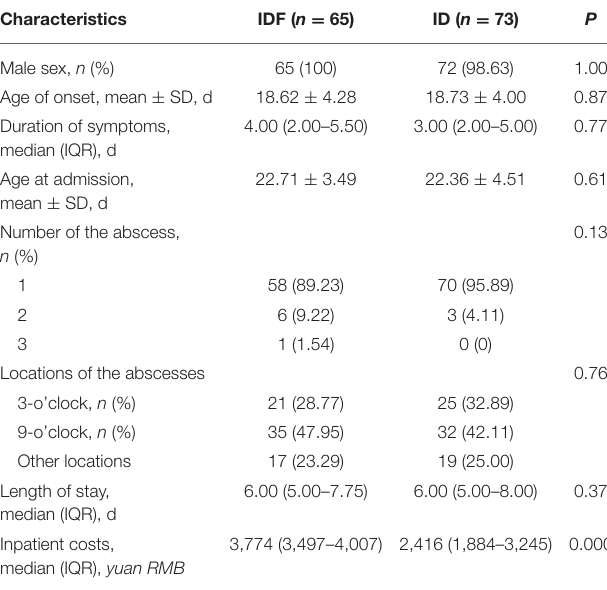
TABLE 1 | Clinical characteristics of neonates with PA.